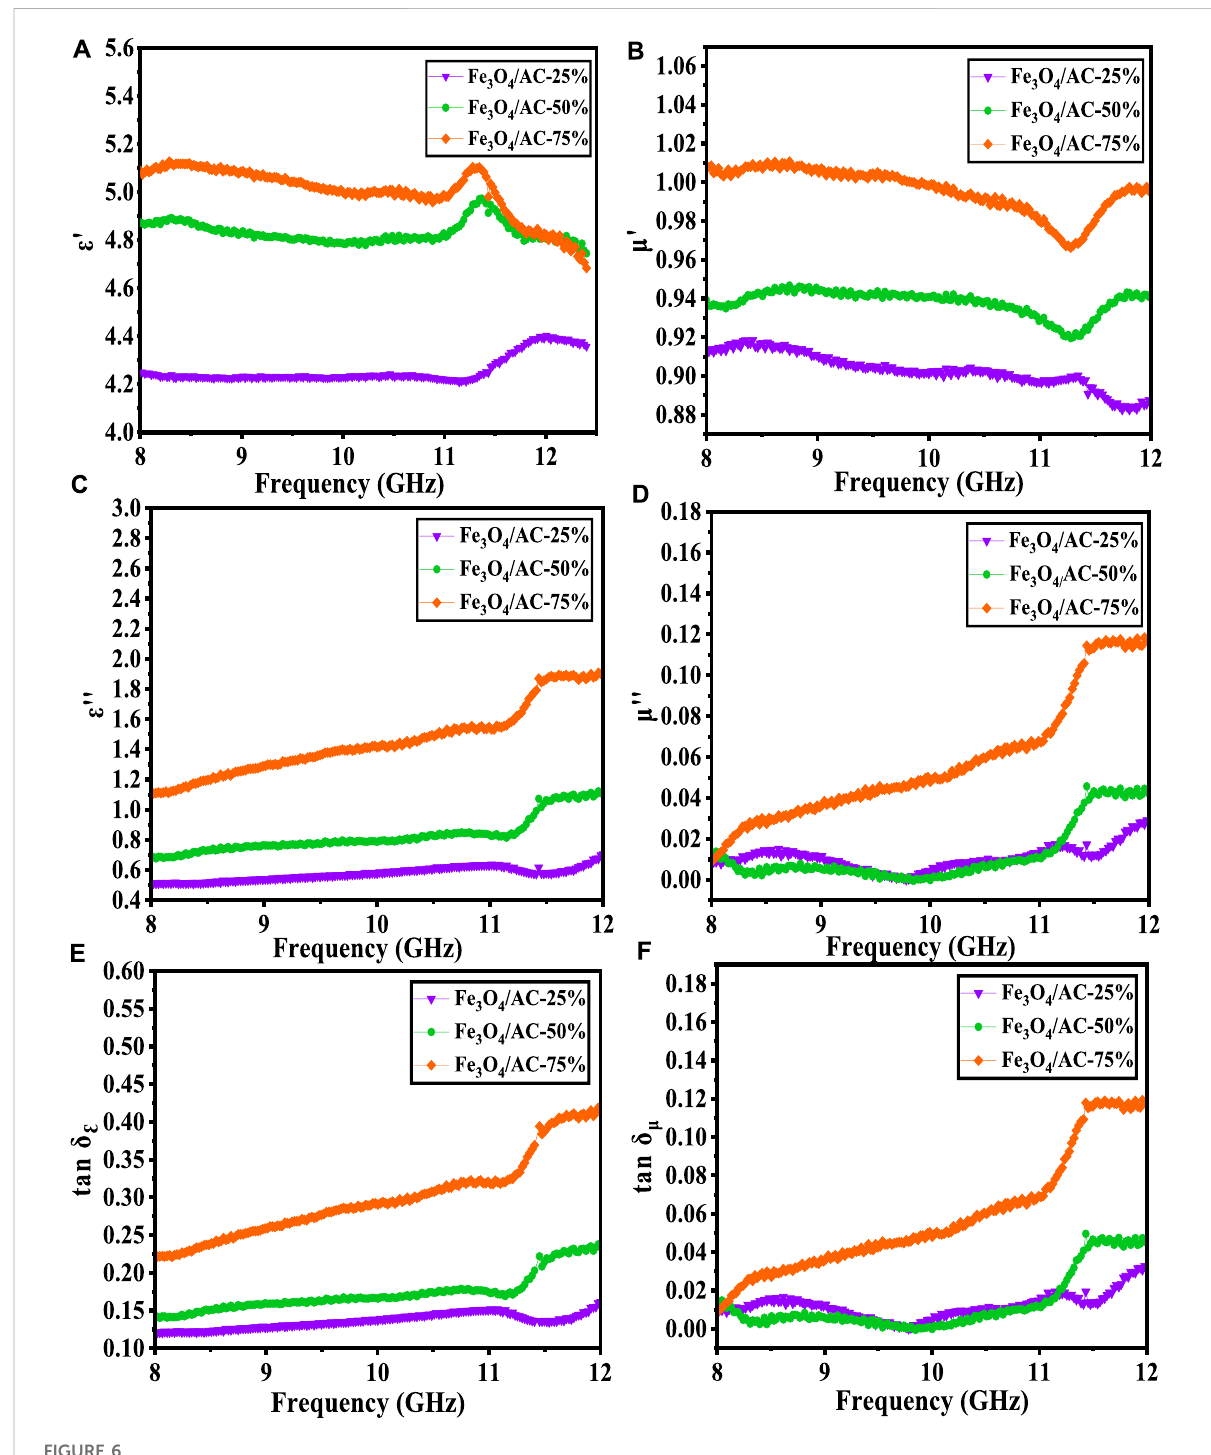
FIGURE 6 (A) Real part, and (B) Imaginary partof complex permittivity. (C) Real part, and (D) Imaginary partof complexpermeability. (E) The dielectric loss tangent and (F) The magnetic loss tangent of the